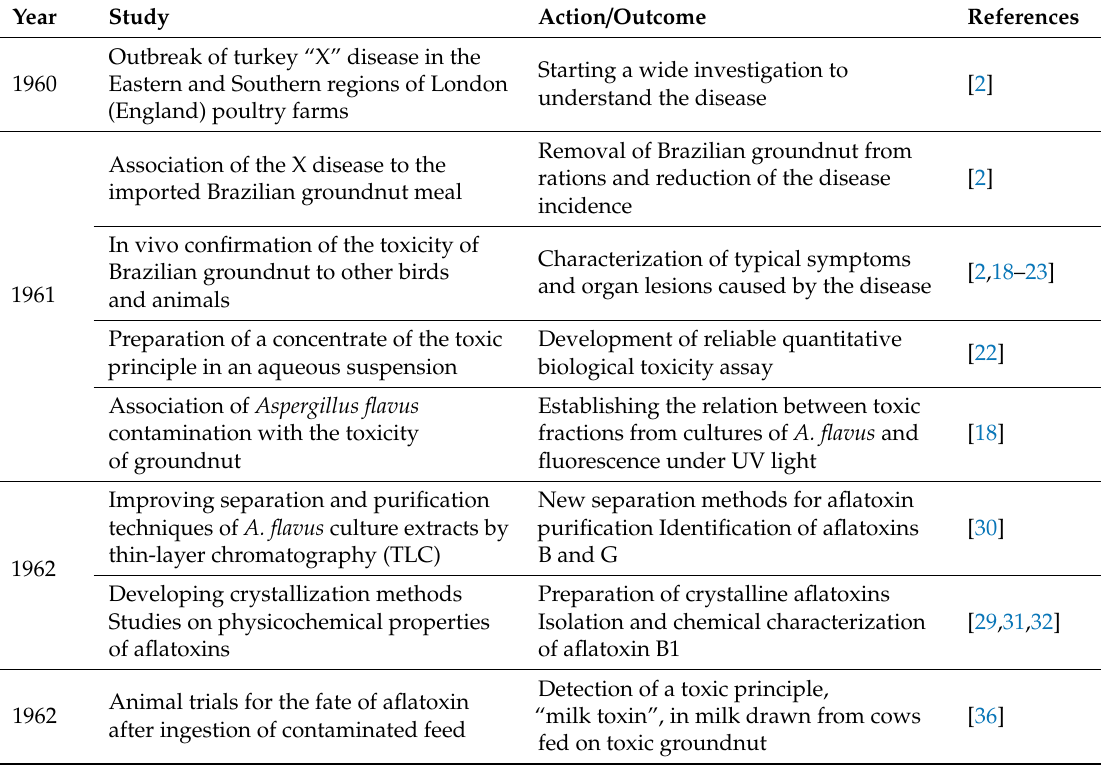
Table 2. Major milestones in the historical and scientific progress leading to the contemporary knowledge on aflatoxins (up-to